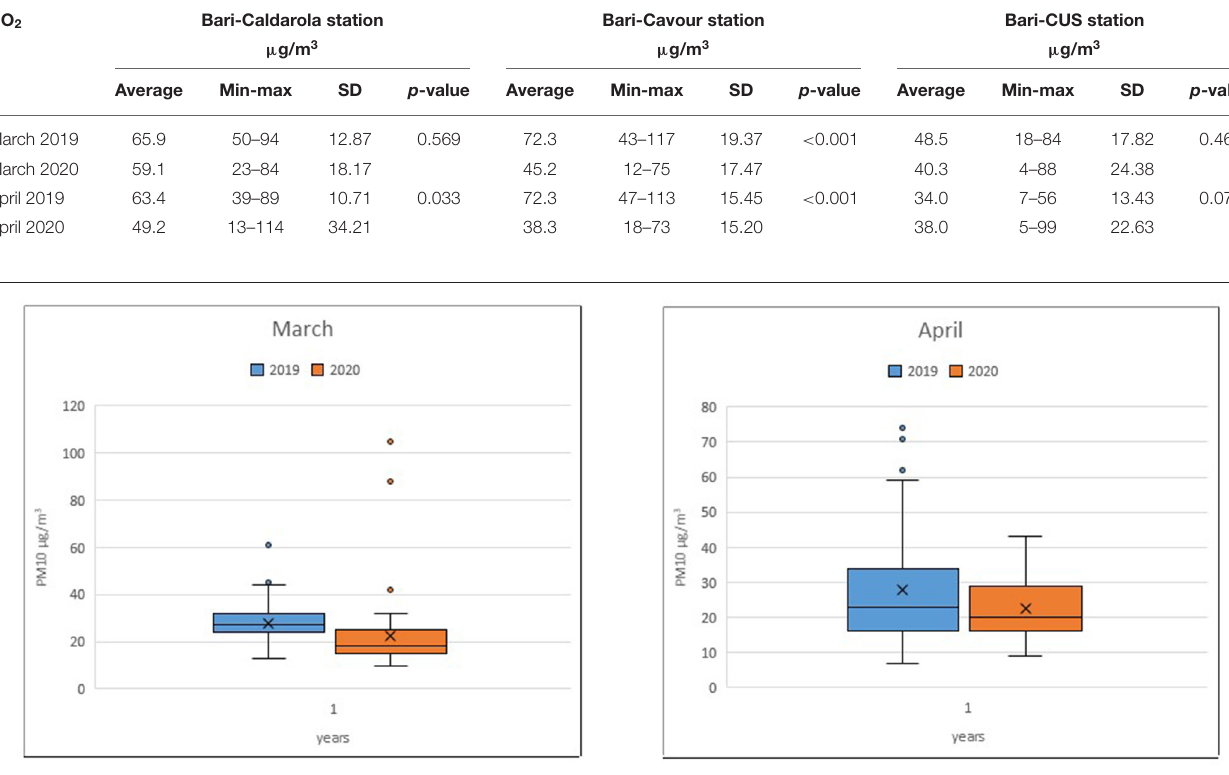
FIGURE 2 | Traffic station PM10 monthly